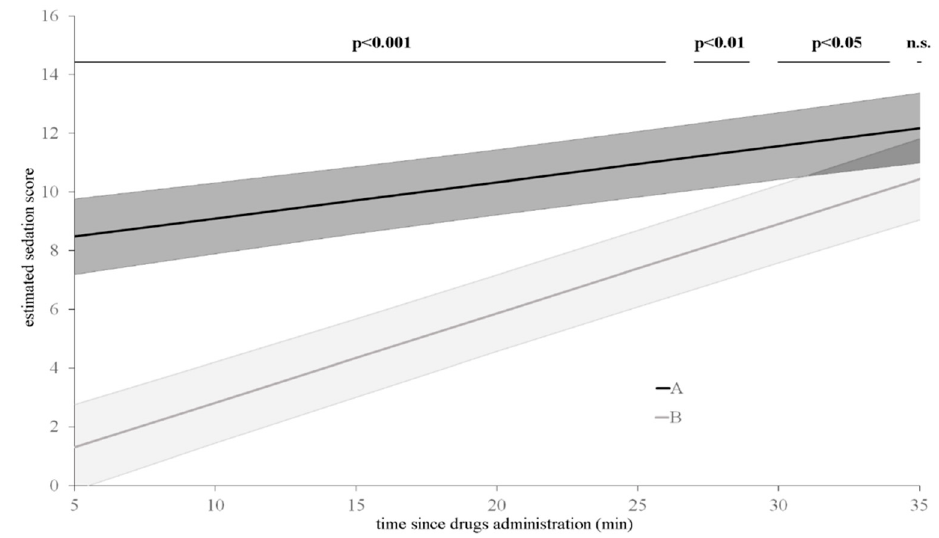
Figure 1. Sedation scores estimated by the model in oral transmucosal (grey line) and intramuscular (black line) treated dogs. Black bars: significance of pairwise comparisons between oral transmucosal and intramuscular administration; n.s.: not significant.